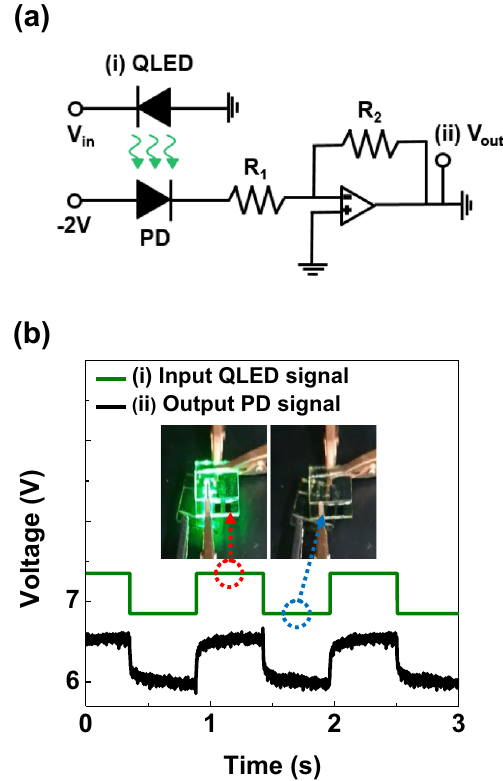
Figure 7. ( a ) Circuit diagram to generate an electrical signal using PD from the light emission of QLEDs. ( b ) Periodic output electrical signal of PD measured at (ii) V out from the input light generated from the (i) dual- functional QLEDs. Inset shows the image of turn-on state QLEDs to generate electrical signal from the PD and turn-off state QLEDs to turn-off the